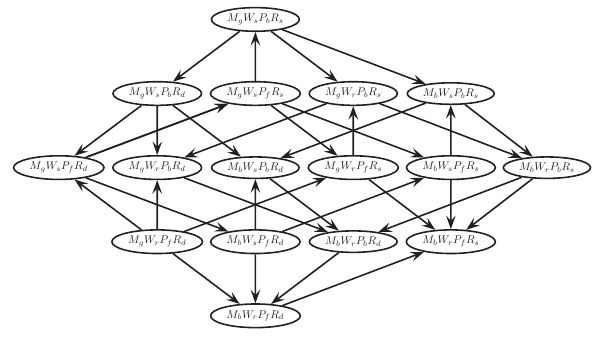
Figure 4. The induced graph of the CP-net “My Weekend